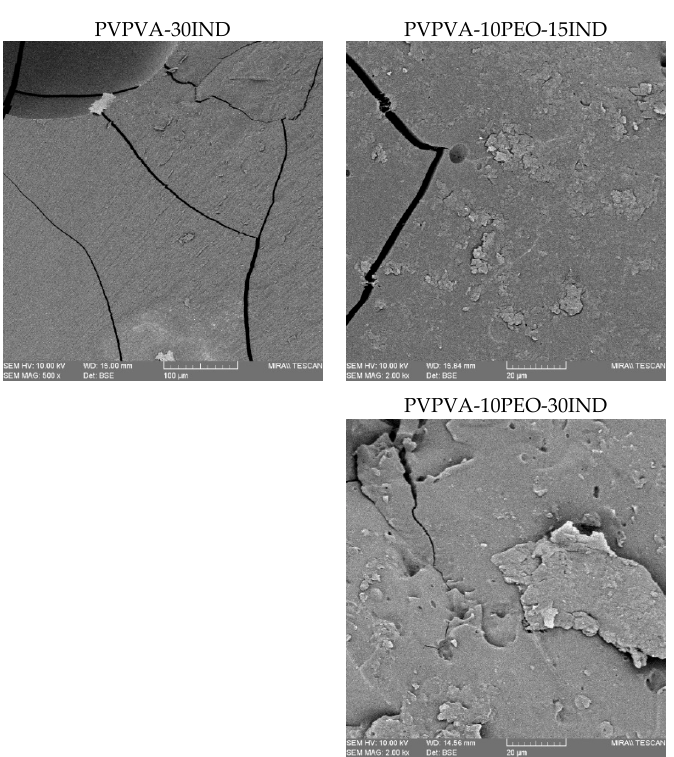
Figure 3. SEM images of µIM tablets.